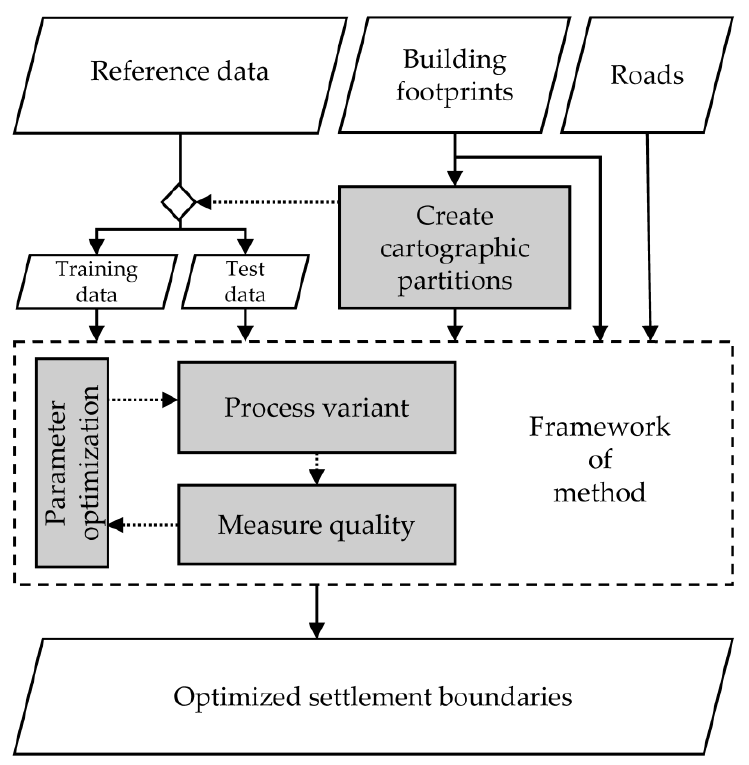
Figure 1. Process chart.